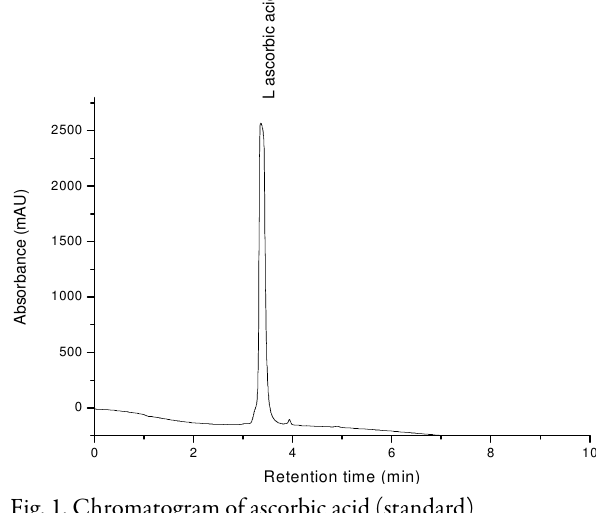
Fig. 1. Chromatogram of ascorbic acid (standard)